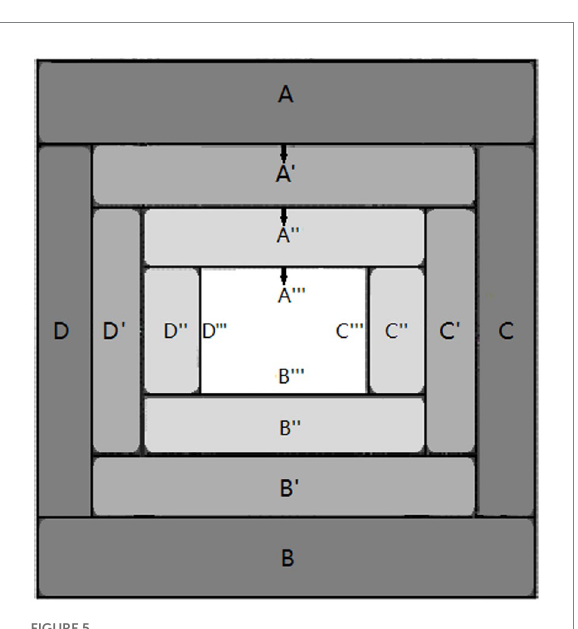
FIGURE 5 Two-dimensional visualization of the Four-layered Catus ̣ kot ̣ i Framework.